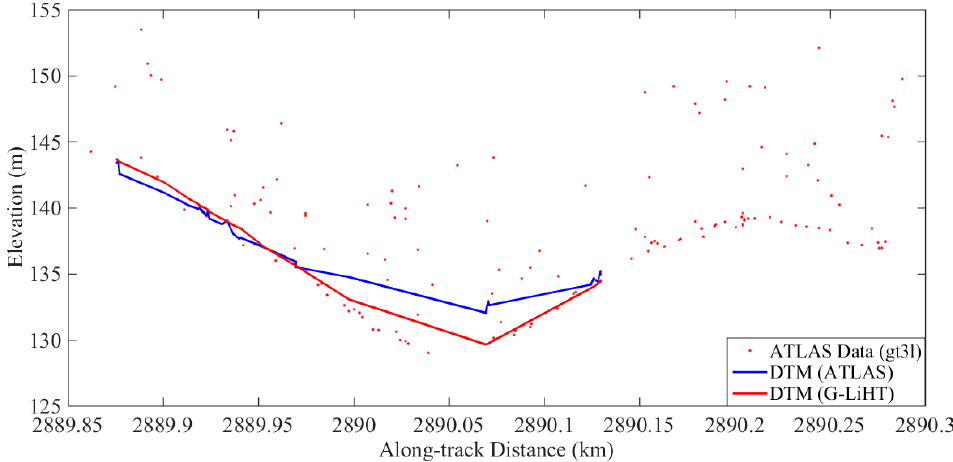
Figure 6. A subset of the forested terrain ATL03 (gt3l) ground topography validation results from track ATL03_20181226053112_13530106_001_01. ATLAS photon data are shown as red dots. The ATLAS DTM (blue line) and the G-LiHT DTM (red line) are also shown.